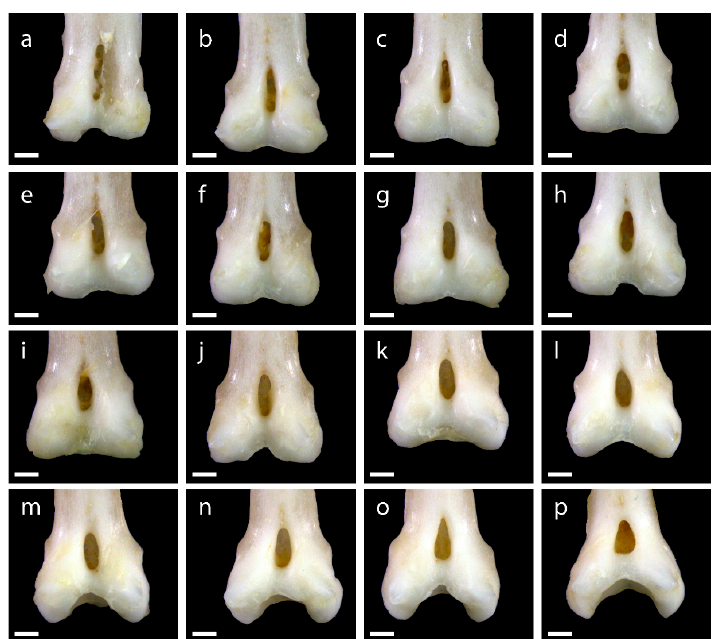
Figure A1. Microscopic images of the posterior view of the pinnules of P. bichir PO1 ( a – p ) correspond to the 1st, 2nd, 3rd, 4th, 5th, 6th, 7th, 8th, 9th, 10th, 11th, 12th, 13th, 14th, 15th, and 16th pinnules, respectively. Scale bars = 1 mm.